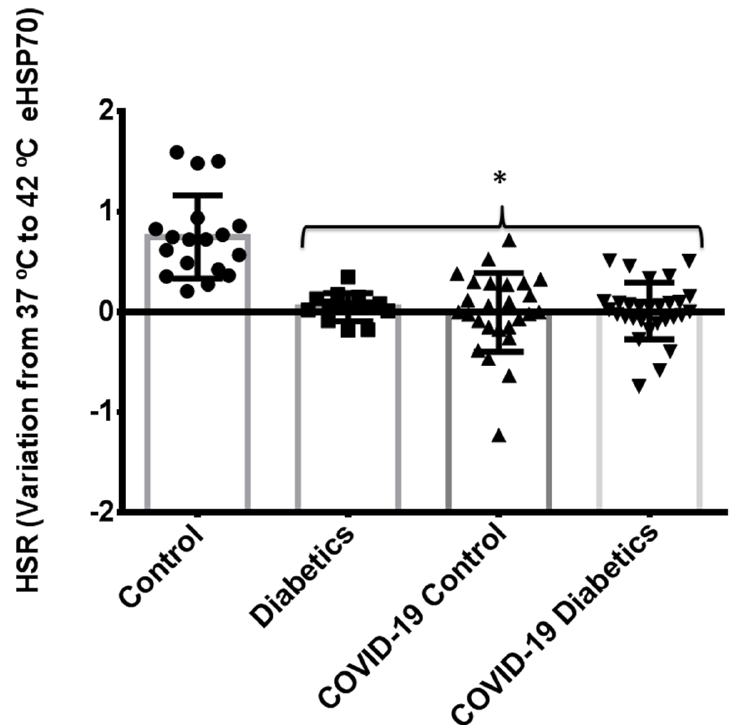
Figure 4. Comparison of the Heat Shock Response between critically ill patients with COVID-19 pneumonia with and without diabetes, noninfected healthy subjects, and noninfected patients with diabetes. Briefly, the collected blood, was immediately incubated (i.e., the whole blood) at two different temperatures: 37 ºC (control) and 42 ºC (heat stressed) for 2 h in a water bath. After the incubation, plasma was collected and used for HSP72 measurements. The difference between concentration at 37 ºC and 42 ºC is used as the HSR index. * When different from noninfected healthy subjects. p <0.05. Data expressed as mean ± S . D .